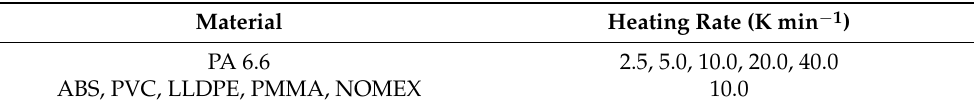
Table 1. Materials tested and heating rates.